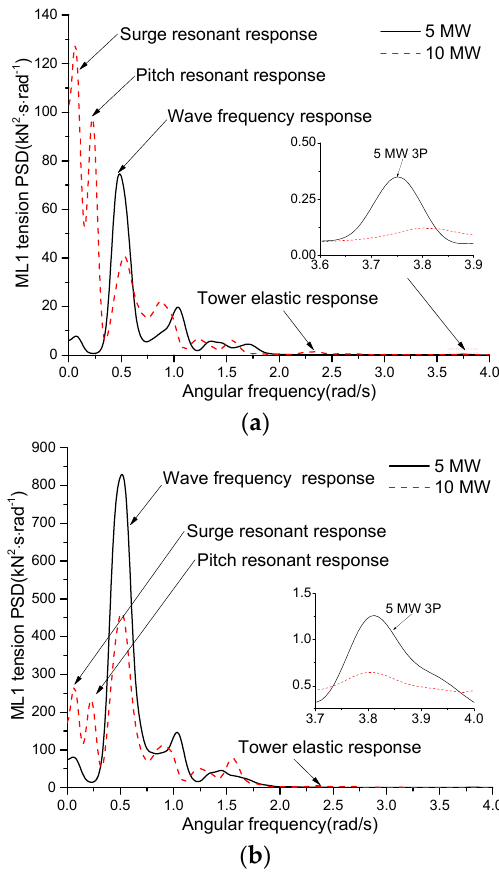
Figure 18. Comparison of the power spectra of Mooring line 1 (ML1) tension response. ( a ) Power spectra of ML1 tension response for the LC3 case; ( b ) power spectra of ML1 tension response for the LC6 case.